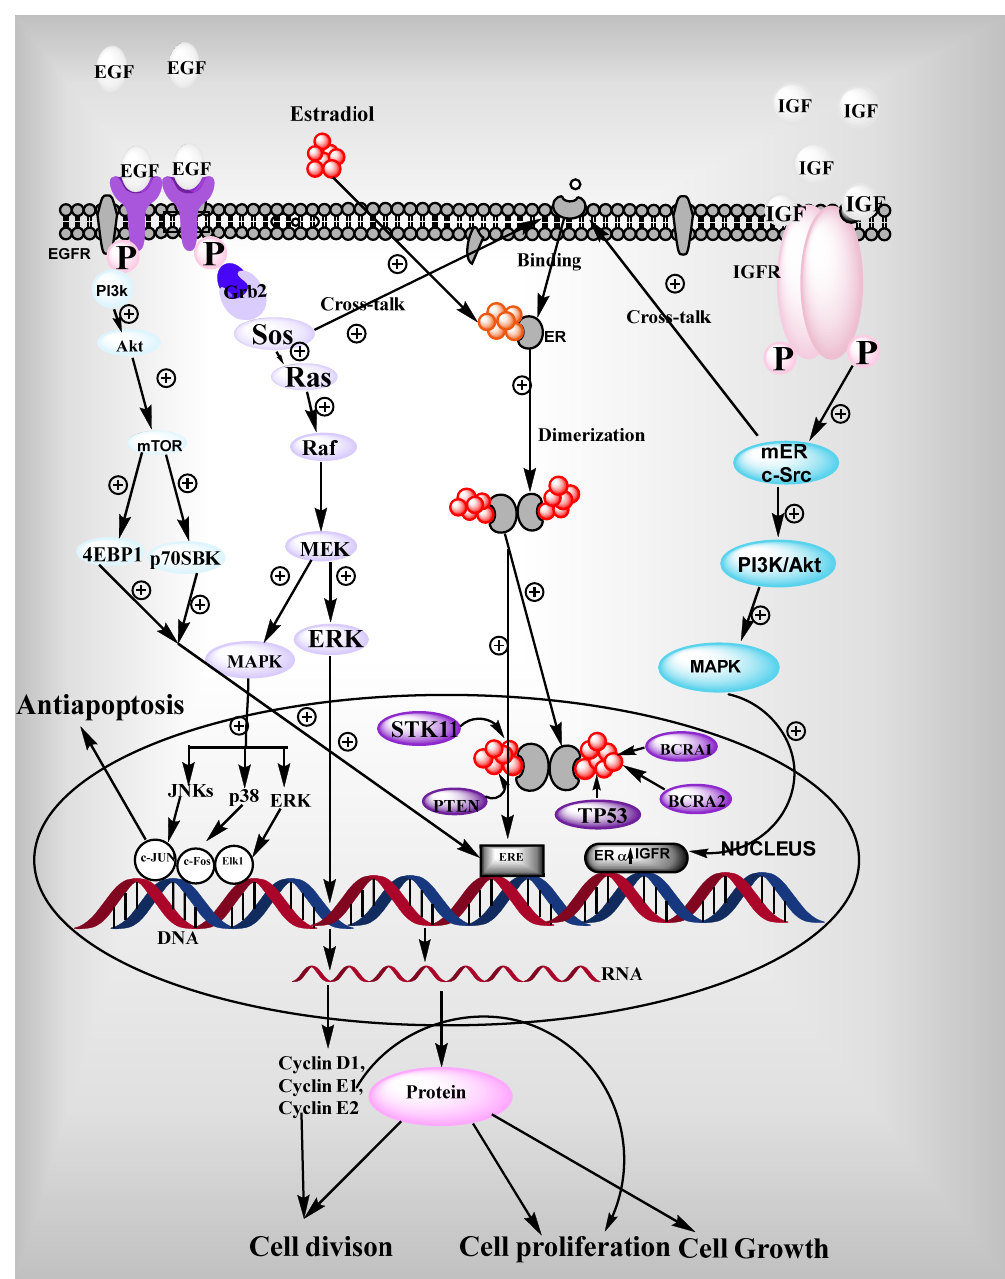
Figure 3. The binding of epidermal growth factor (EGF) with EGFR activates the receptor signaling due to phosphorylation. It stimulates various intracellular kinases signaling such as PI3K, Ras, MAPK, mTOR and induces cell division, proliferation, and growth. It interferes with other cellular signaling, such as IGFR, ER. It shows crosstalk with ER, which is present on the membrane, simultaneously cell signaling starts and the formation of proteins.